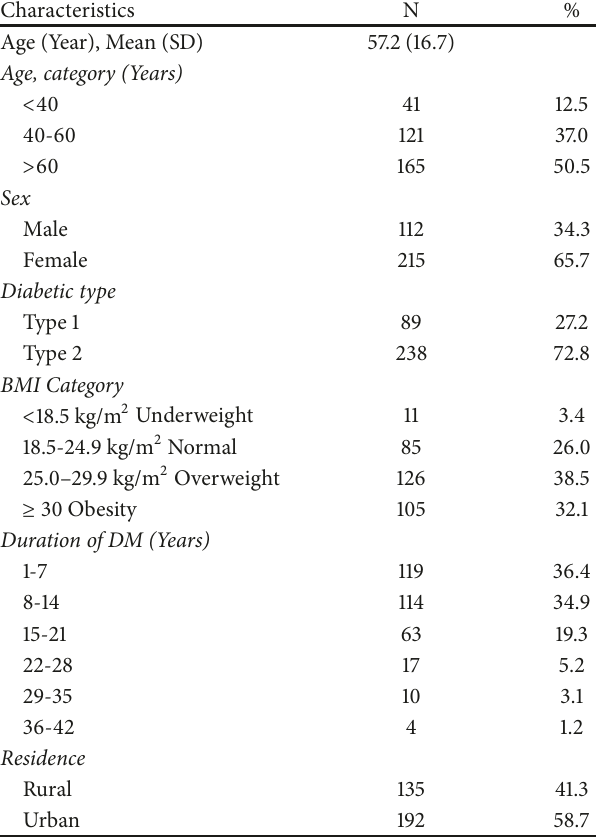
Table 1: Demographic characteristics of participants (n=327). Table 2: Medical and physical profiles among diabetic peripheral neuropathy